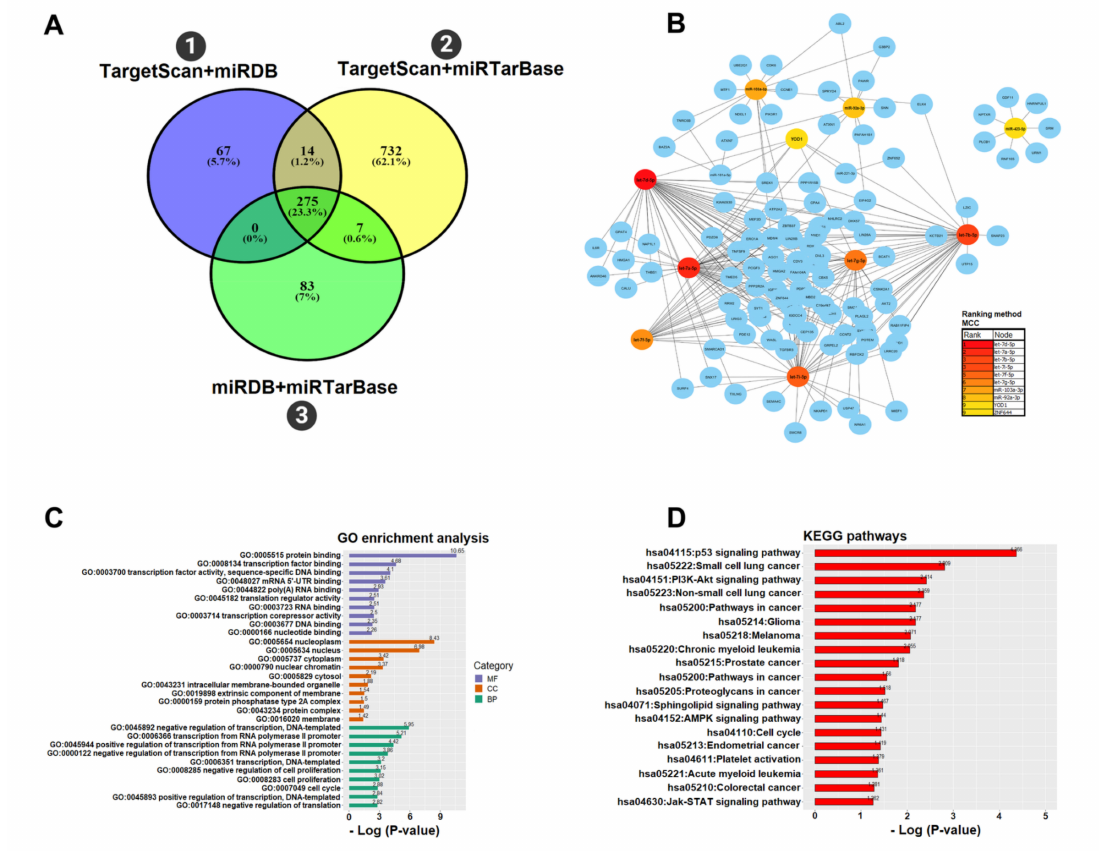
Figure 6. ( A ) Three subsets of data obtained with target prediction with miRWalk generated 67 (5.7%) interactions in file (1) TargetScan + miRDB, 732 (62.1%) of interactions in file (2) TargetScan + miRTarBase and 83 (7%) of interactions in file (3) miRDB + miRTarBase. Both files share 275 (23.3%) interactions at the same time; ( B ) The network of miRNA–gene interactions built with Cytoscape using the maximal clique centrality (MCC) method that was applied to identify regions of denser connections of miRNA–gene interactions. The nodes are represented by the red, orange, and yellow gradient circles that were ranked by the MCC. The edges are identified by circles in blue; ( C ) The most enriched GO terms in three functional categories, i.e., molecular function (MF), cell component (CC), and biological process (BP) for the main genes of the network constructed from 275 miRNA–gene interactions; ( D ) The main KEGG pathways for the functional enrichment of genes in this network were normalized with -Log 10 ( p